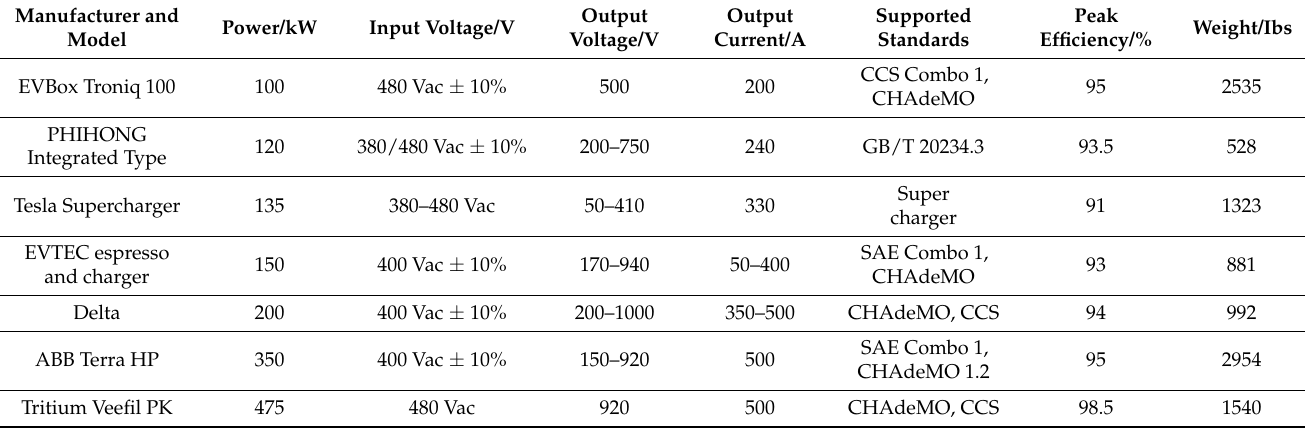
Table 2. Characteristics of the 100-kilowatt-class of fast/ultra-fast-charging systems.